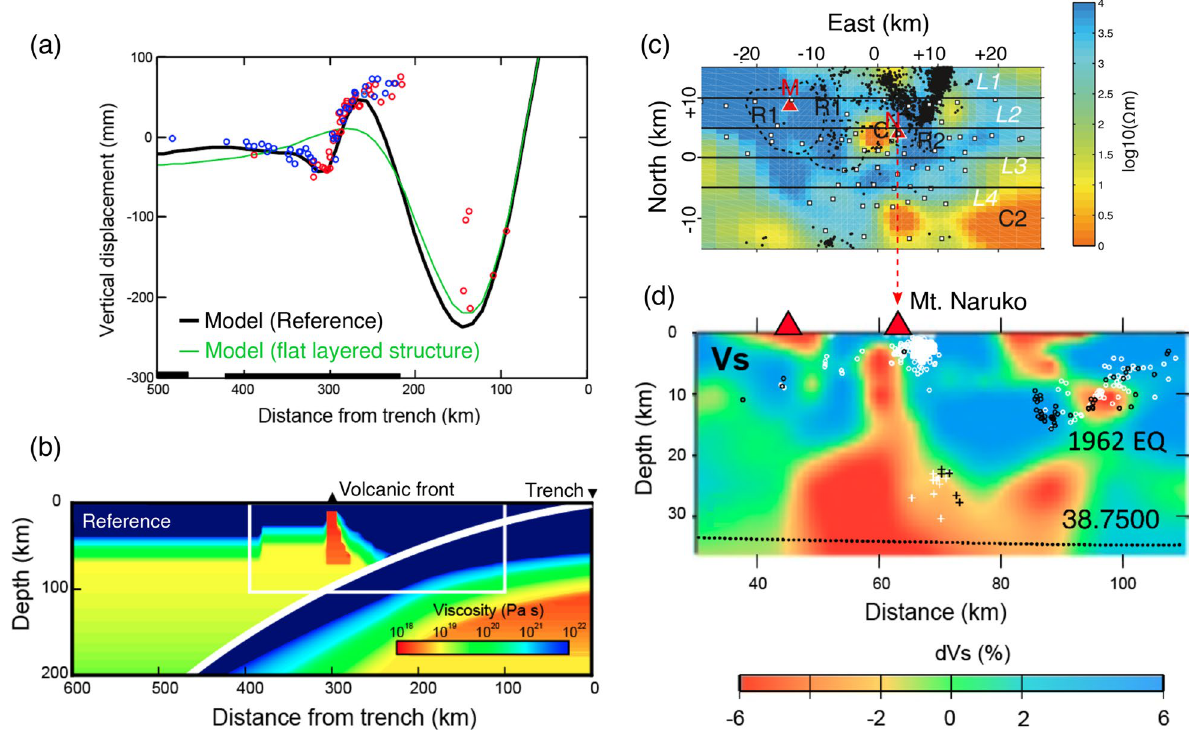
Fig. 12 a Two-dimensional projection of observed and modeled displacements along Miyagi-Yamagata area (Muto et al. 2016). The blue and red points denote GNSS observations from GEONET and Tohoku university network, respectively. b Two-dimensional viscosity structure across Mt. Naruko region (after Muto et al. 2016). c Map view of resistivity distribution (at 5 km depth) around Mt. Naruko by magnetotelluric survey (after Ogawa et al. 2014). d S-wave tomography for the same transects (after Okada et al.